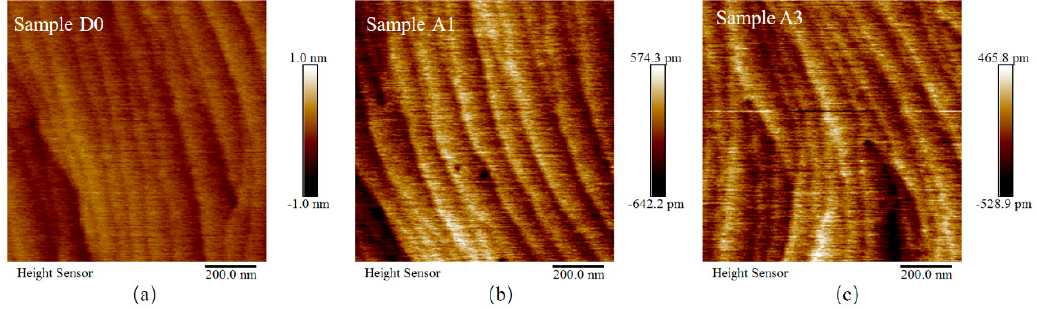
Figure 2. Atomic force microscopy surface images of samples D0, A1 and A3 in 1 µ m × 1 µ m regions. Color bar is shown at the right side of each figure.